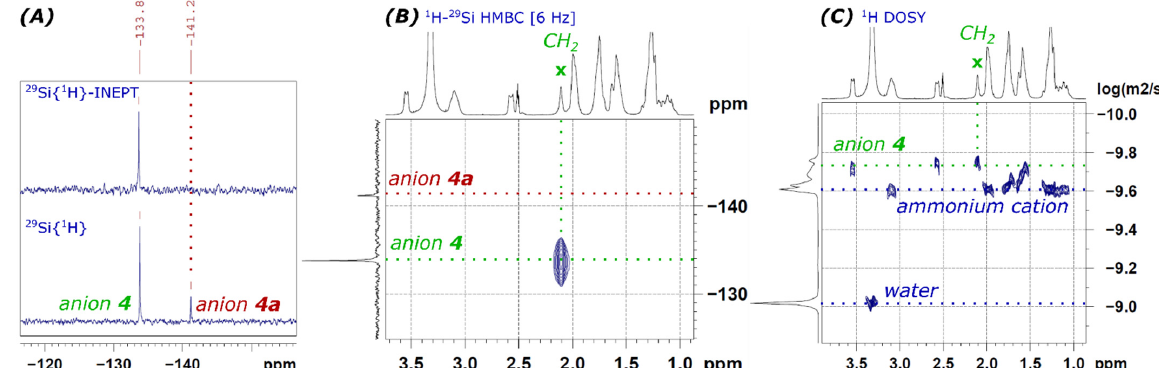
Figure 1. Crucial 29 Si and diffusion NMR spectra for the elucidation of the [Si(C 6 O 2 Br 4 ) 3 ] 2 − anion 4a . ( A ) 29 Si{ 1 H} and 29 Si-INEPT spectra in comparison. ( B) Well-acquired 1 H– 29 Si HMBC spectrum optimized on long-range J = 6 Hz. ( C ) 1 H DOSY spectrum processed by the monoexponential fitting. All spectra were acquired at +50 ◦ C in DMSO- d 6 to prevent a slow rotational dynamic of sterically hindered molecules. In the 29 Si-INEPT and 1 H– 29 Si HMBC spectra, only RCH 2 [SiO 4 ] − was visible with the presence of protons near the silicon atom. In the 1 H DOSY spectra, also only anion 4 was visible, in the form of two anionic and cationic parts with different diffusion coefficients. Proton free anion 4a was invisible in all spectra except direct long acquisition of the 29 Si (marked by red dot line), which was the best confirmation of its structure.